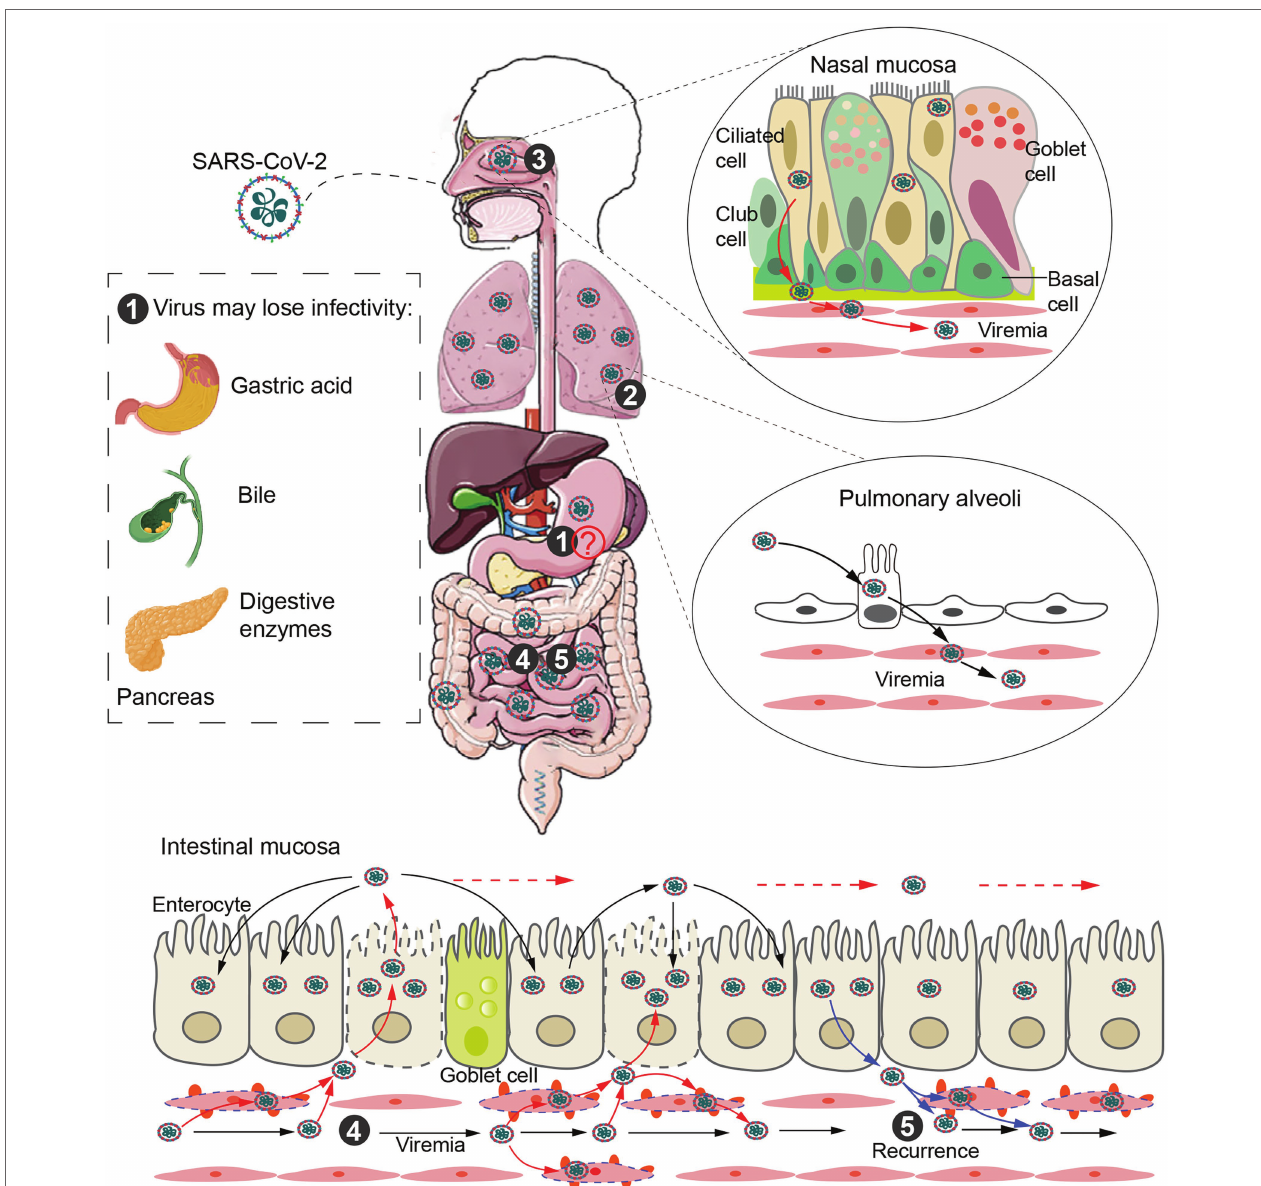
FIGURE 1 | Intestinal infection and transmission routes. ① Direct evidence for fecal–oral transmission is still lacking. SARS-CoV-2 may be unable to enter the small intestine from the stomach due to gastric acid, bile and digestive enzymes. ② SARS-CoV-2 released from type II alveolar cells infects alveolar capillary endothelial cells (ECs). The virus replicates in ECs and is released into the blood to form viremia. ③ SARS-CoV-2 is released from infected ciliary cells of the nasal cavity and breaks through the basement membrane, infecting the vascular ECs and eventually entering circulation. ④ Blood transmission after alveolar or nasal infection is a potential route of intestinal infection. Eventually, SARS-CoV-2 is released into the gut and infects surrounding intestinal epithelial cells along the intestinal tract. ⑤ SARS-CoV-2 in the gut can also enter the capillaries and cause viremia, leading to recurrence of